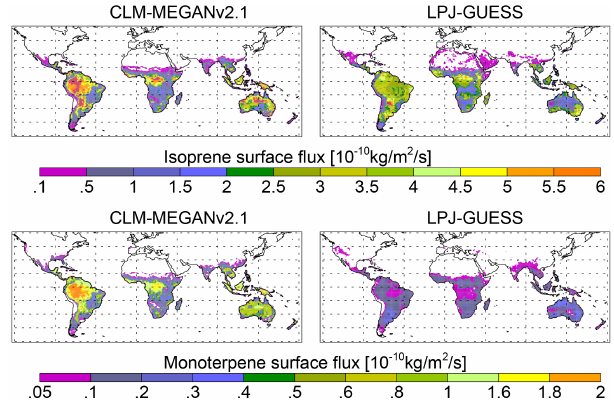
Figure 2. Isoprene and monoterpene emission distributions from CLM-MEGANv2.1 and LPJ-GUESS for January